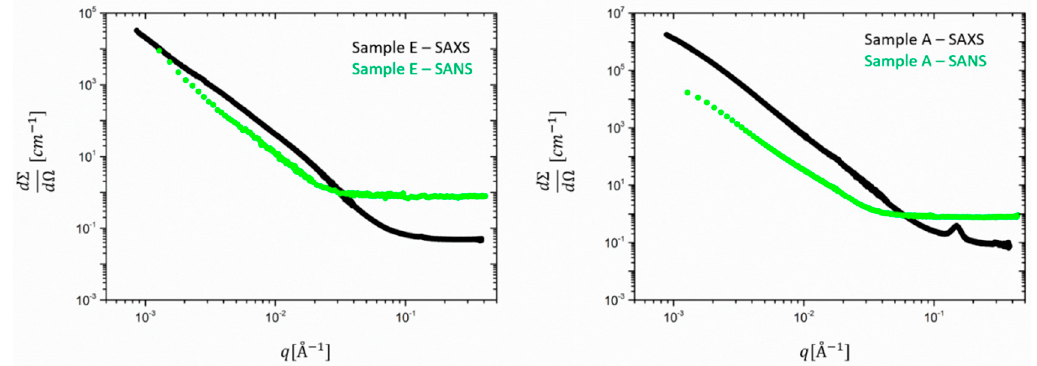
Figure 1. Absolutely calibrated SAXS (black) and SANS (green) data for samples E (left) and A (right). The data are not background-corrected.